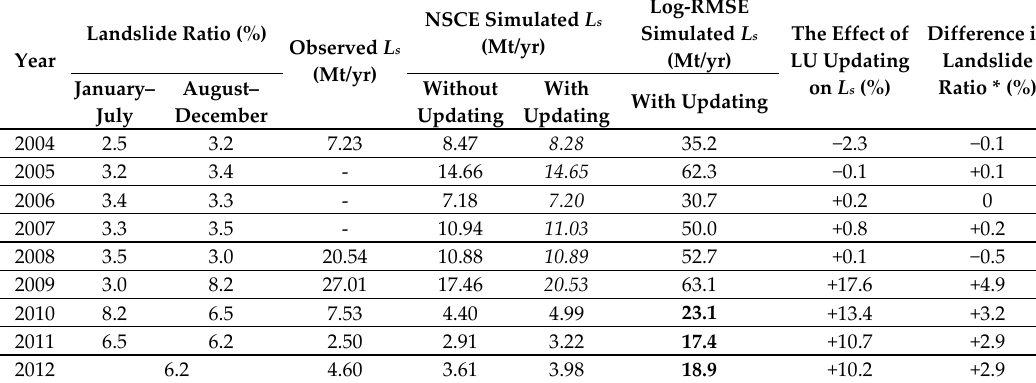
Table 6. Comparison between observed, NSCE simulated (w/wo landslide updating) and log-RMSE simulated annual suspended sediment yield simulation with and without the use of landslide